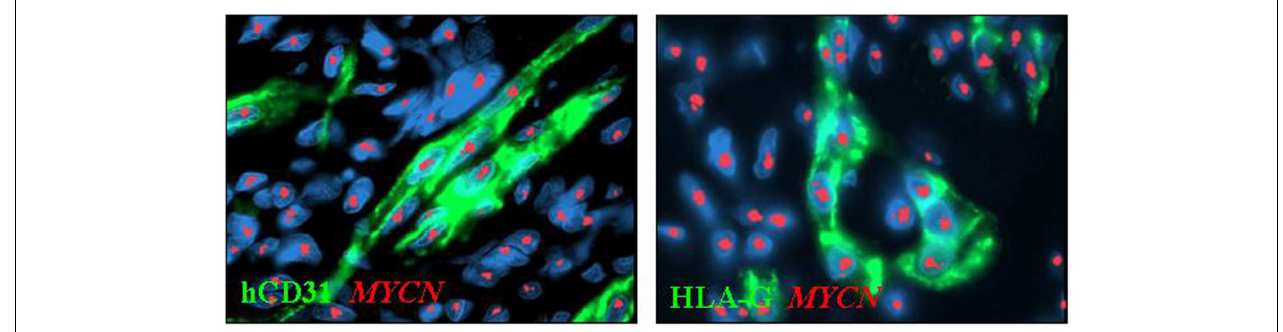
Immunofluorescence analyses show the expression of human (h)CD31 and HLA-G inTEC. Nuclei are stained with DAPI (blue). Original magnification 100 ×